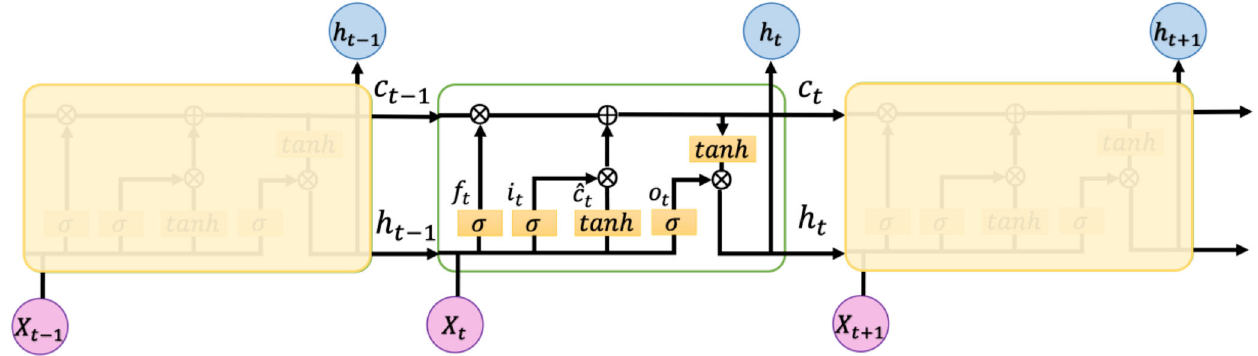
Fig. 4 The internal structure of LSTM, including the forget gate, input gate, and output gate. The pink circle represents the input of different moment, the blur circle represents the hidden state of different